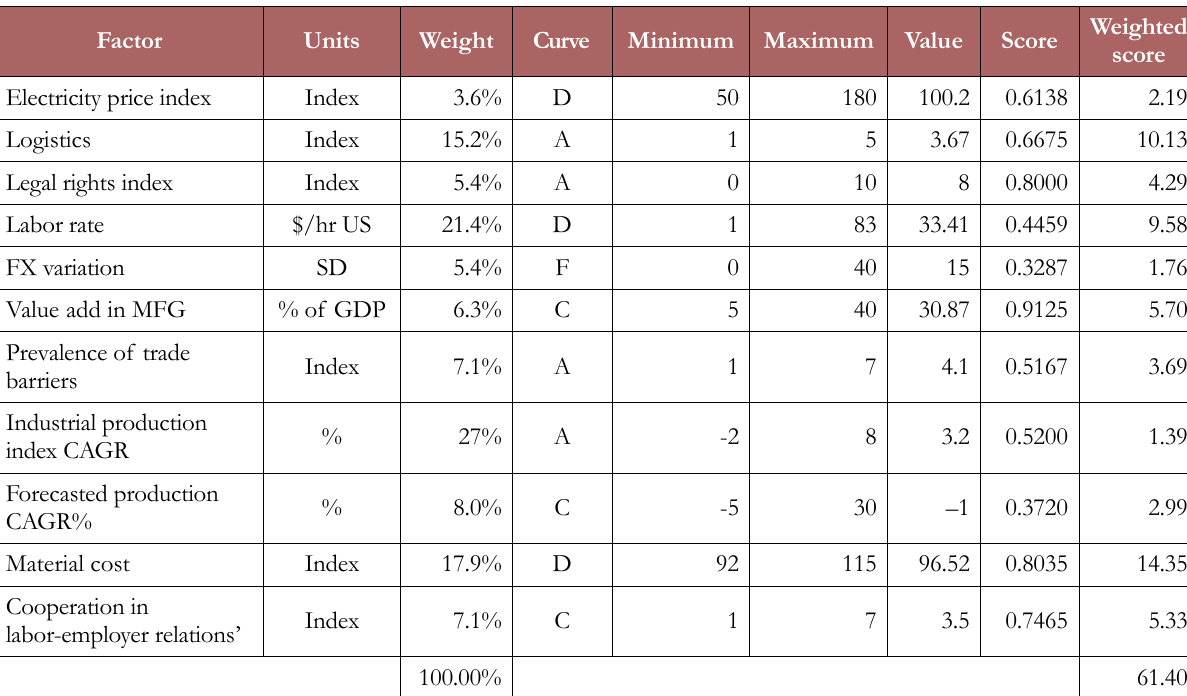
Table 5. Example matrix for South